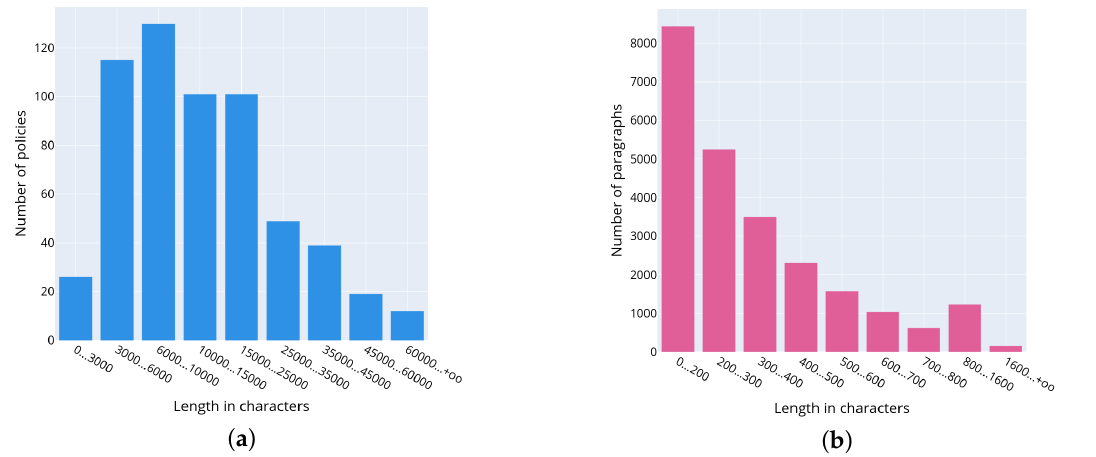
Figure 3. Characteristics of privacy policies of the corpus: ( a ) distribution of privacy policies by length in characters; ( b ) distribution of lengths of privacy policy paragraphs in